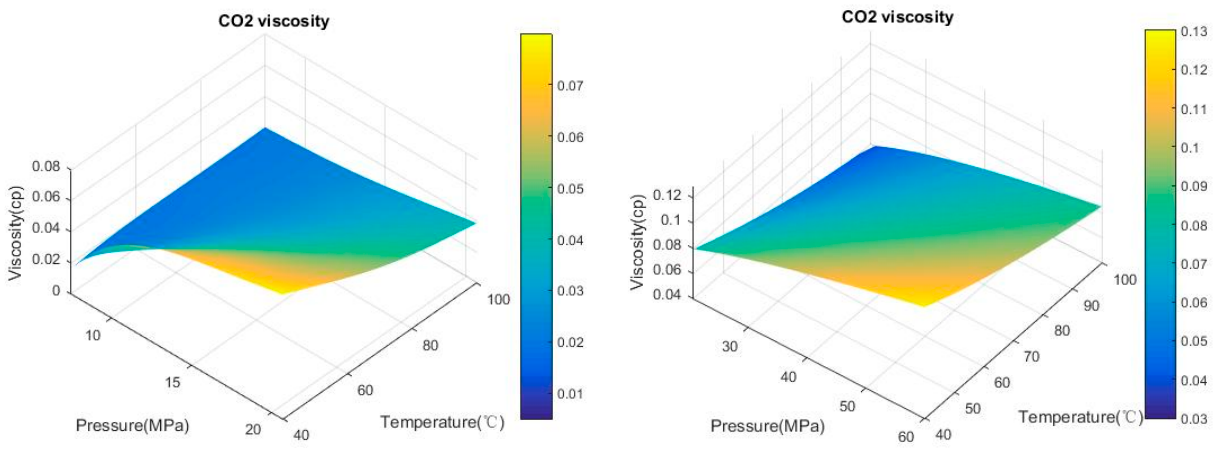
Figure 2. The relationship between SC-CO 2 viscosity and temperature-pressure.